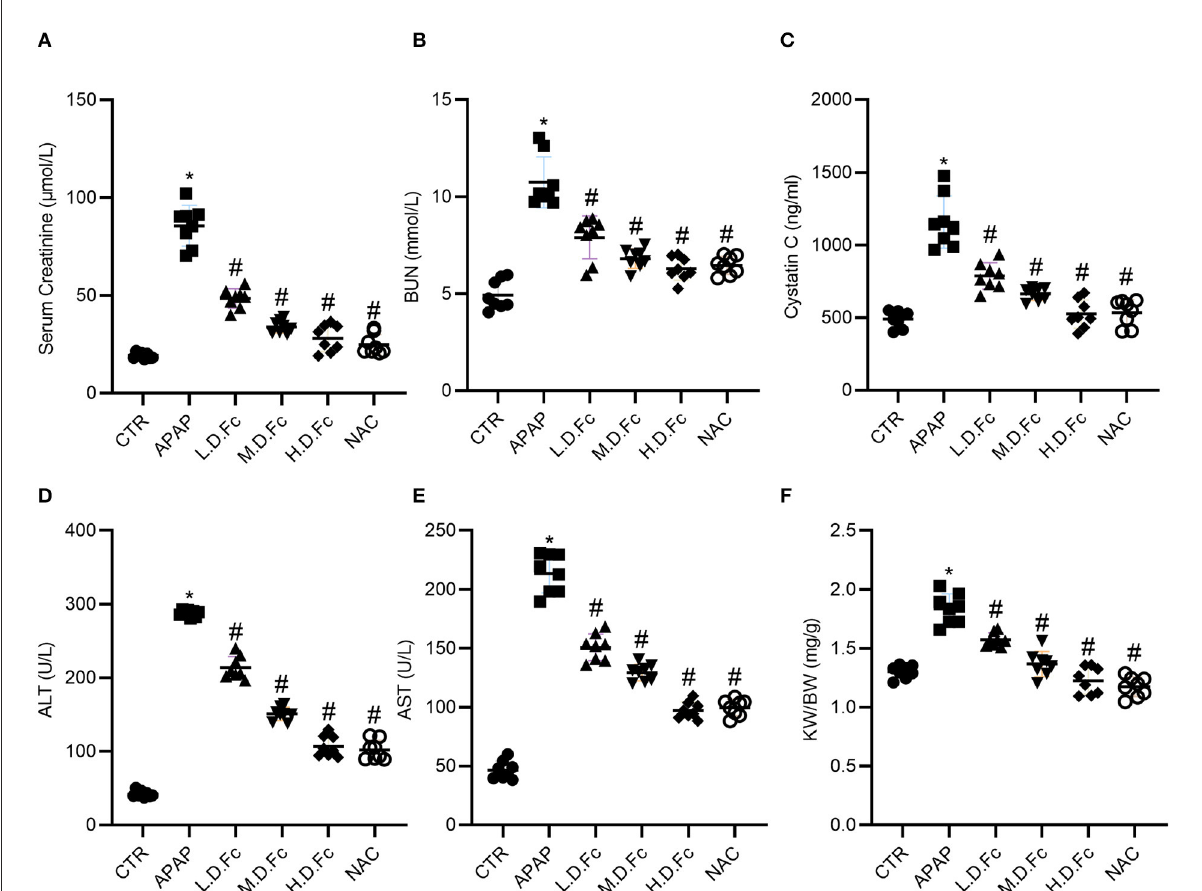
FIGURE1 Effects of Notoginsenoside Fc on Biochemical Parameters of Serum Caused by APAP. (A) The levels of serum creatinine. (B) The levels of BUN. (C) The levels of Cystatin C. (D) The levels of alanine aminotransferase (ALT). (E) The levels of aspartate aminotransferase (AST). (F) The renal index (KW/BW). Results were expressed as mean ± SD ( n = 8). * P < 0.05 vs. normal control mice. # P < 0.05 vs. APAP-induced AKI